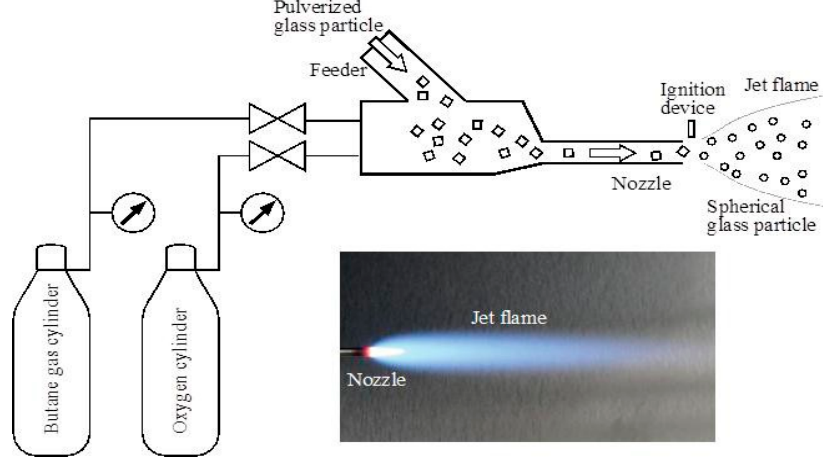
Figure 3. Process of prepared bead-type RPL glass dosimeter using Jet-frame method.